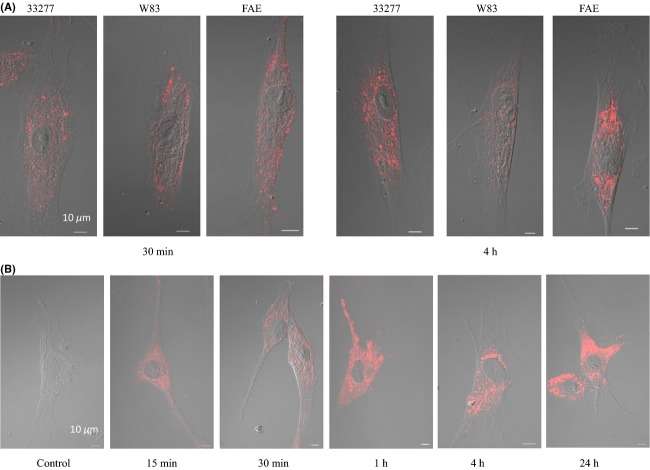
Visualization of intracellular vesicles in human gingival fibroblasts (HGFs) with confocal microscopy. (A) HGFs were grown in a glass bottom dish for 16 h, and then infected with Porphyromonas gingivalis vesicles (0.5 μg) isolated from 33277, fimA mutant (FAE), and an afimbriated strain (W83) strains. Cells were examined by confocal microscopy at 30 min and again at 4 h. Internalized vesicles were probed with anti-P. gingivalis polyclonal antibodies, visualized by Alexa Fluor 546-conjugated anti-rabbit IgG secondary antibody, and presented by differential interference contrast (DIC) imaging. (B) HGFs were treated with or without (control) 33277 vesicles for 15 min to 24 h as shown. As in (A), vesicles were probed with anti-P. gingivalis polyclonal antibodies and visualized by Alexa Fluor 546-conjugated anti-rabbit IgG secondary antibody.